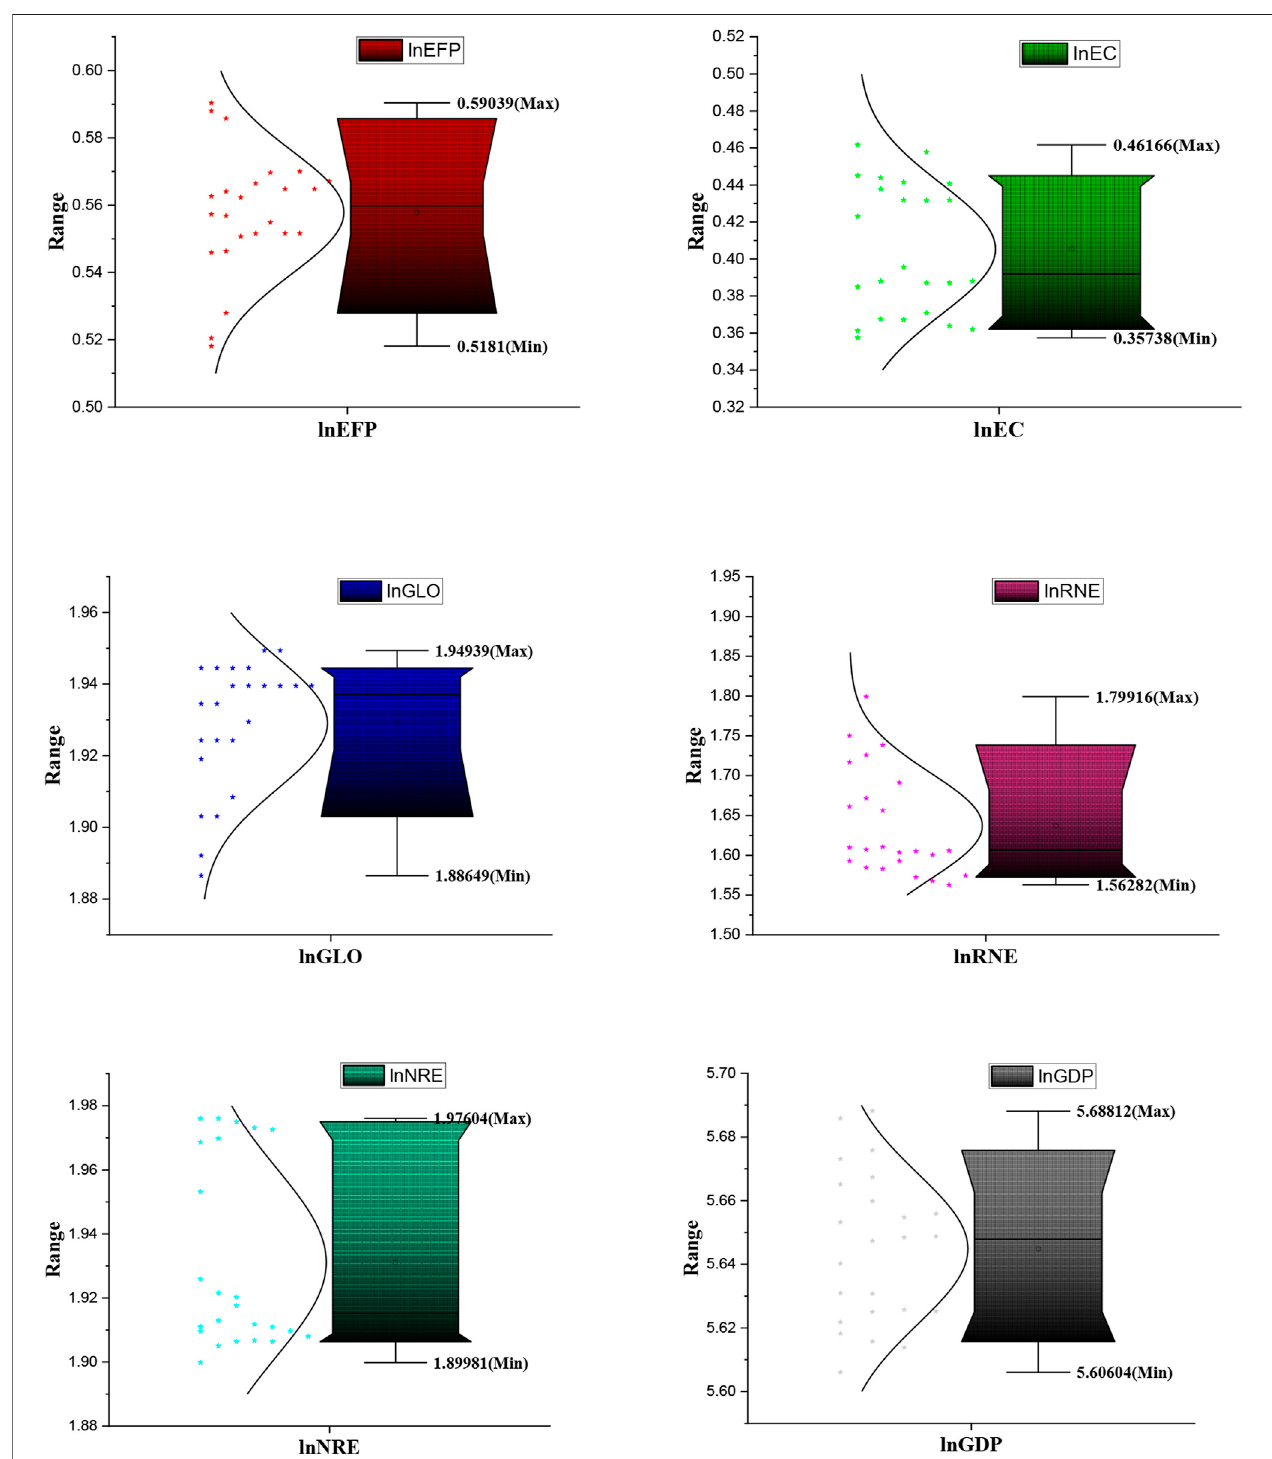
FIGURE 2 | Summery statistics of the Box-plot of the concerned series.